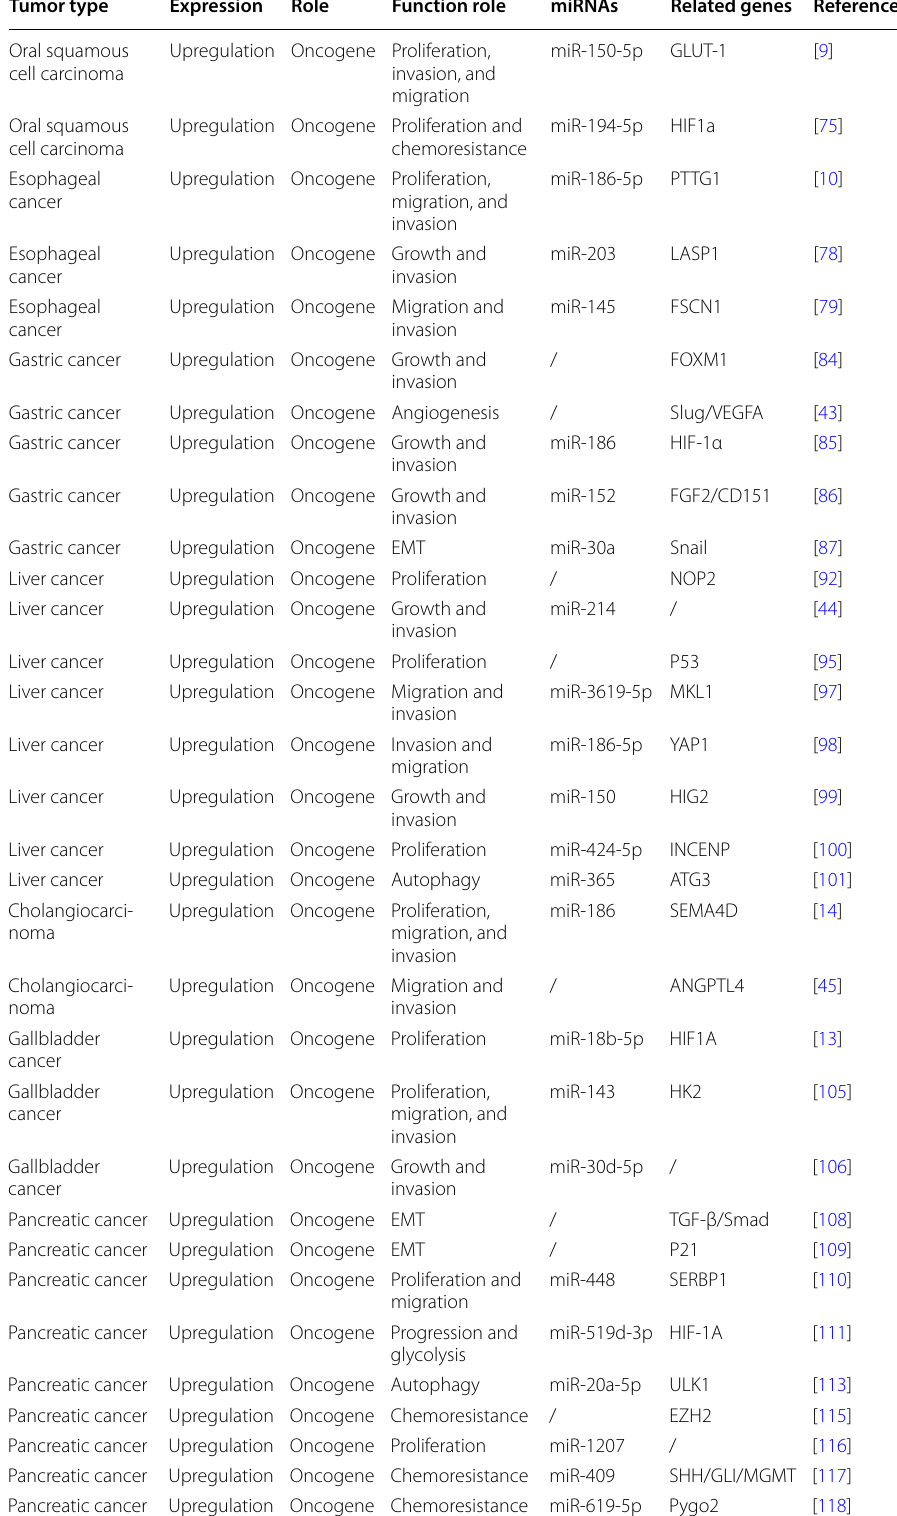
Table 3 Functional characterization of PVT1 in digestive system tumors Tumor